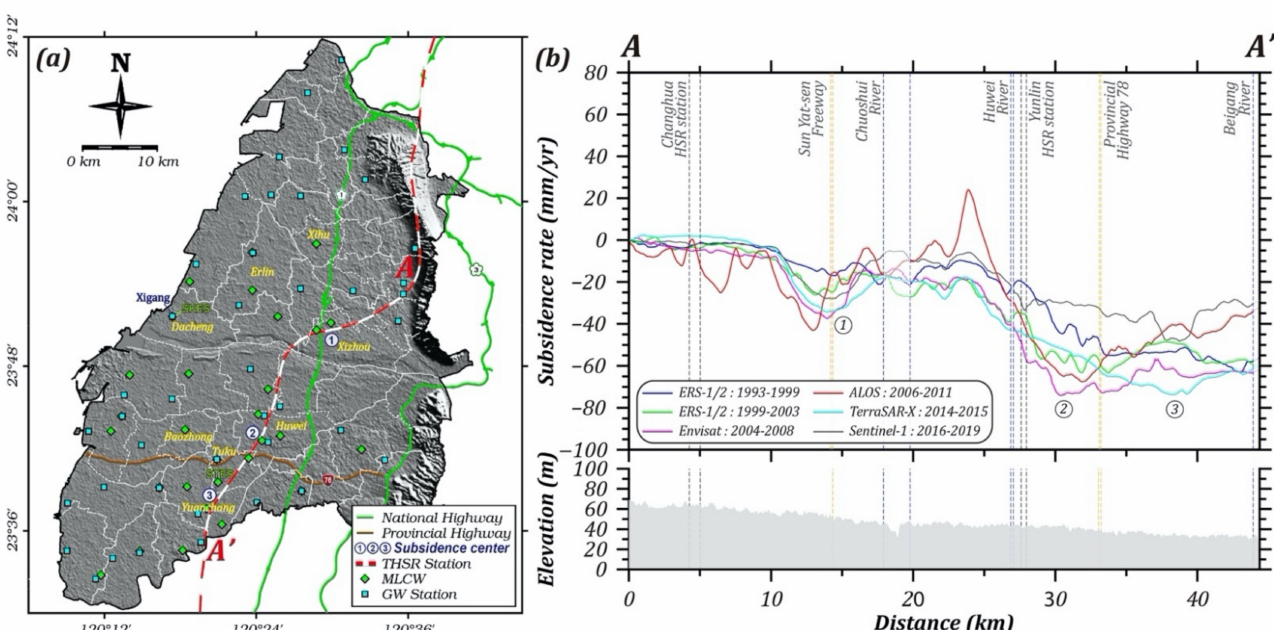
Figure 7. ( a ) The distribution of main subsidence centers along the THSR. ( b ) Vertical displacement rates along the A–A’ section of the THSR over the CRAF. The blue, green, pink, red, light blue, and gray lines represent the rates derived from the InSAR measurements. The gray, yellow, and blue vertical dash lines represent the location of THSR stations, traffic arteries, and rivers, respectively. Three evident subsidence centers occurred in the Xizhou section (zone 1; zone number is encircled), the Huwei to Tuku section (zone 2), and the Tuku to Yuanchang section (zone 3). A subsidence in zone 3 first formed in